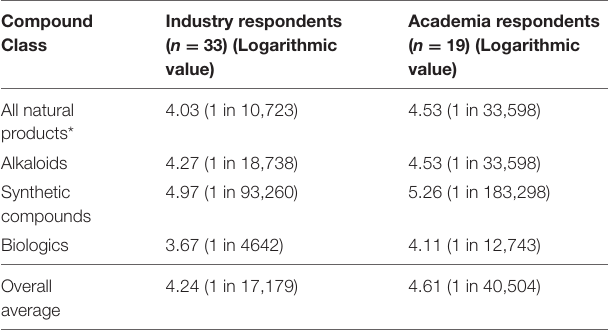
TABLE 3 | Respondent’s estimates of how many agents researched commercial R&D facilities make it to market as pharmaceutical products (defined as the “hit